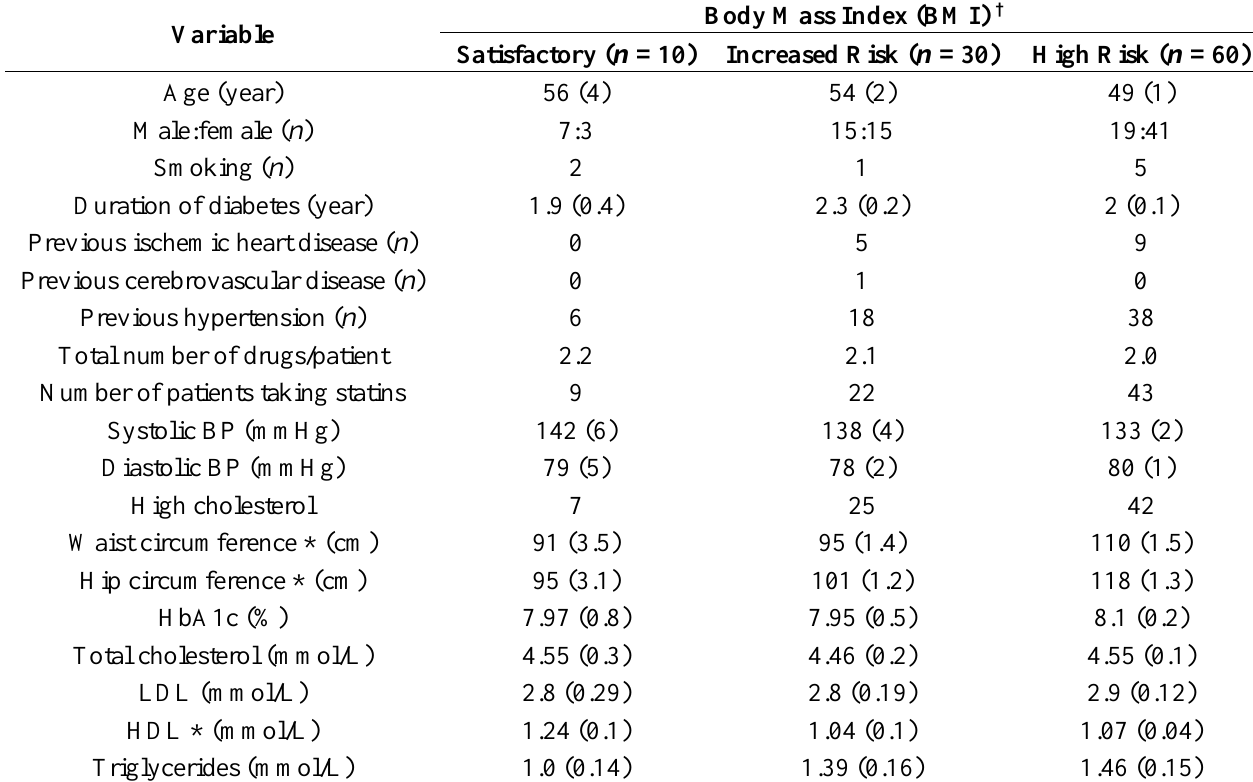
Table 1. Baseline characteristics according to the BMI cut-off-points for non-Asian populations (mean SE).